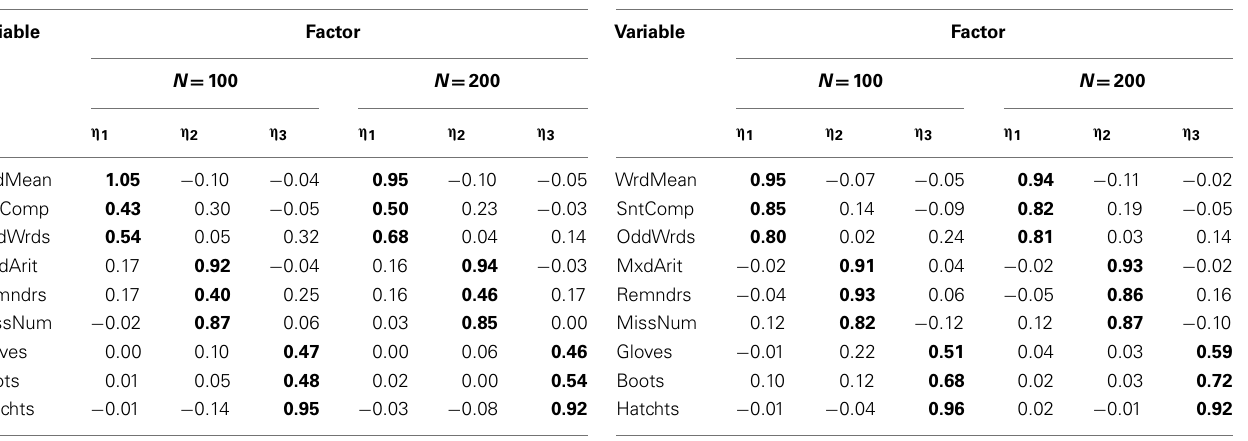
Table 13 |Three-factor model loading matrix obtained with EFA of product-moment R among Case 4 item-level